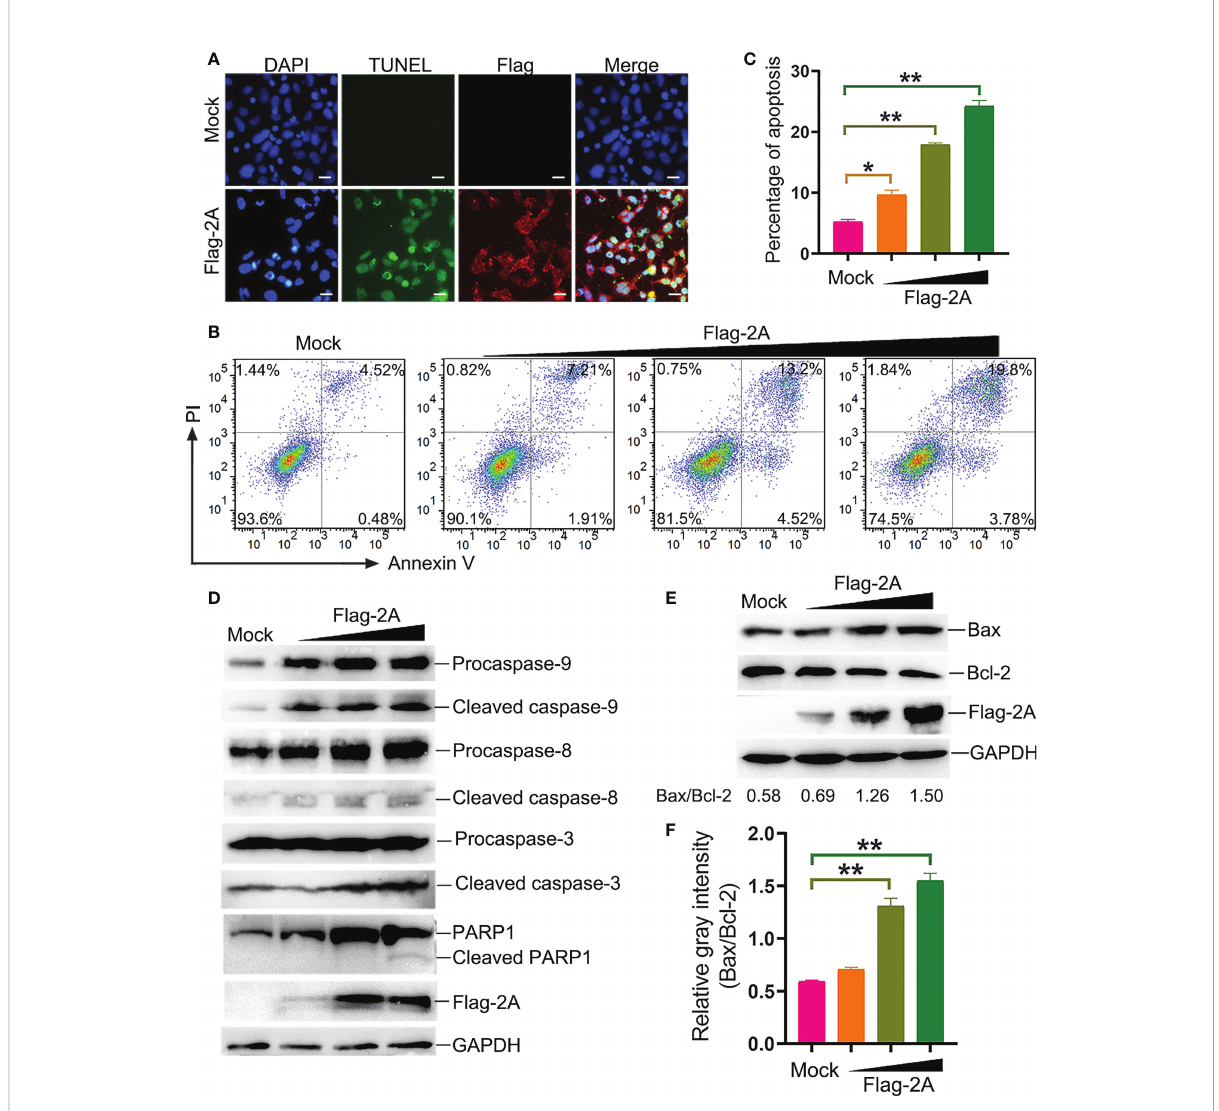
FIGURE 6 PSV 2A induces apoptosis. (A) The PSV 2A-transfected cells were fi xed and incubated with TUNEL (green), anti-Flag antibody (red), and DAPI at 24 h, and then observed under fl uorescence microscope. Scale bar: 100 m m. (B, C) The 2A-transfected cells were stained with Annexin